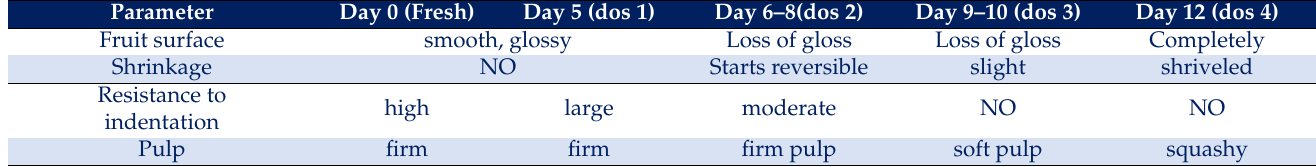
Table 3. Physical and sensory properties for Bell pepper fruit irrespective of colour.